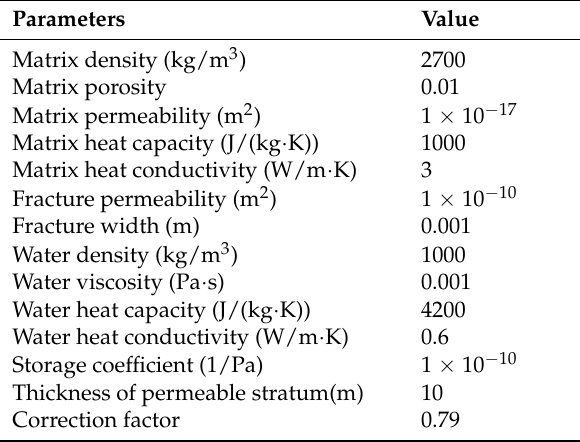
Table 2. Model Parameters.